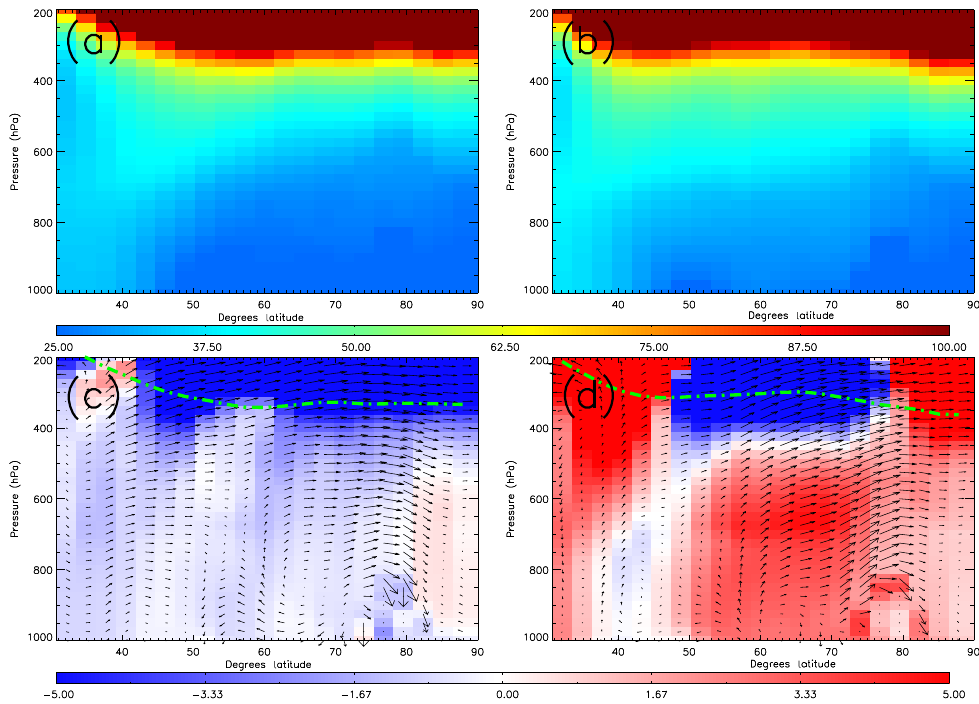
Figure 15. TOMCAT ozone (ppbv) cross section at 56.25 ◦ W averaged between 2006 and 2015 sampled under the wintertime (NDJF) NAO. Panel (a) NAO positive phase, (b) NAO negative phase, (c) shows the NAO positive phase anomaly relative to the wintertime average and (d) shows the negative NAO phase anomaly relative to the wintertime average. Green dashed lines represents the dynamical tropopause. Wind vectors represent the cross section (56.25 ◦ W) meridional and vertical (scaled by 10 4 )